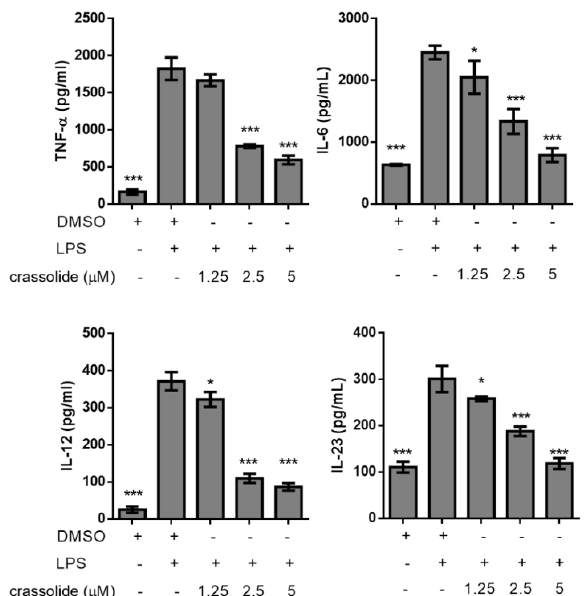
Figure 3. Effects of crassolide on lipopolysaccharides (LPS)-induced cytokines production in bone marrow-derived dendritic cells (BMDCs). BMDCs were treated for 2 h with either various doses of crassolide, or 0.1% DMSO, followed by LPS stimulation (100 ng/mL) for 24 h. Cytokines in the culture supernatants were measured by ELISA. Data are presented as mean ± SEM of triplicate samples from one of three independent experiments. * p < 0.05, *** p < 0.001, versus LPS + 0.1% DMSO-treated group, tested by one-way ANOVA followed by Tukey’s multiple comparison